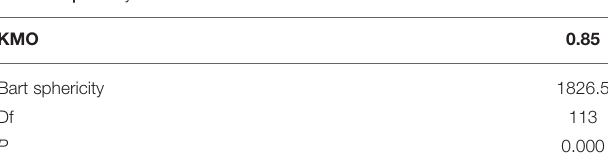
TABLE 2 | Validity test